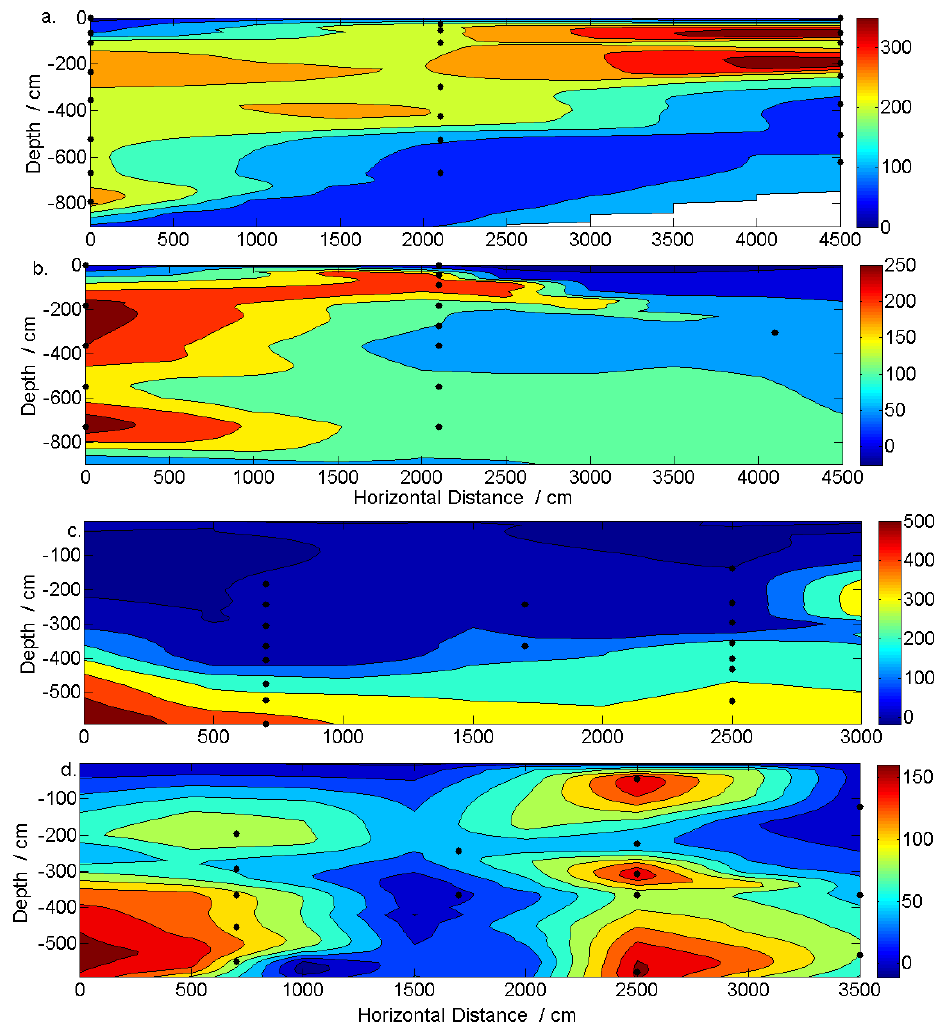
Figure 2. Cross section of Nitrous oxide (N 2 O) concentrations (nmol·L −1 ) for Port Jefferson Harbor in ( a ) May and ( b ) October and Stony Brook Harbor in ( c ) May and ( d ) October. Black dots (●) indicate individual porewater sampling points.